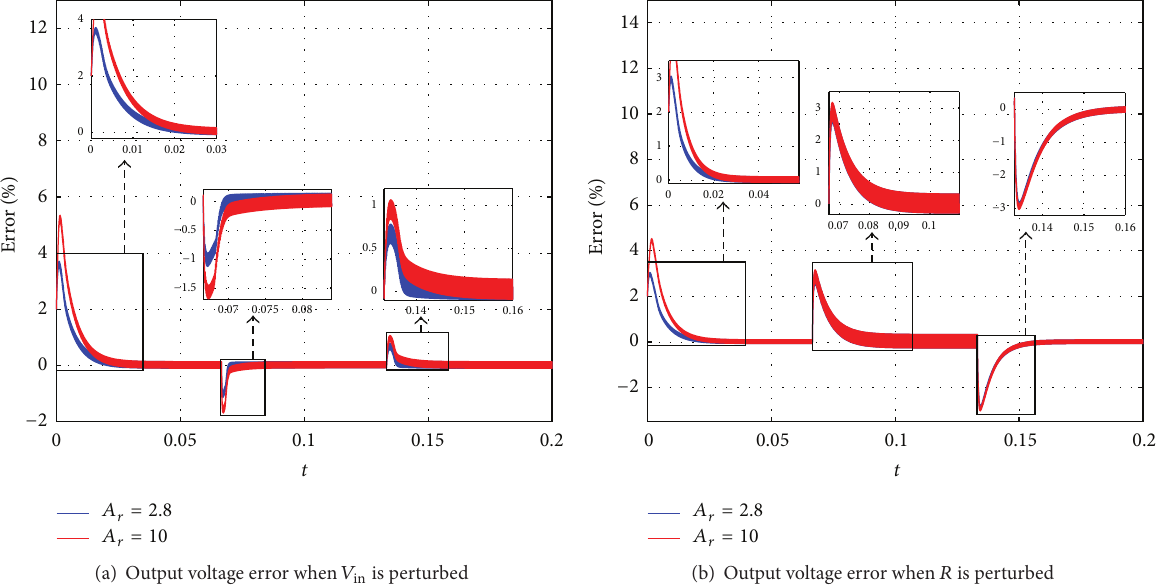
Figure 8: Error response for different values of 𝐴 𝑟